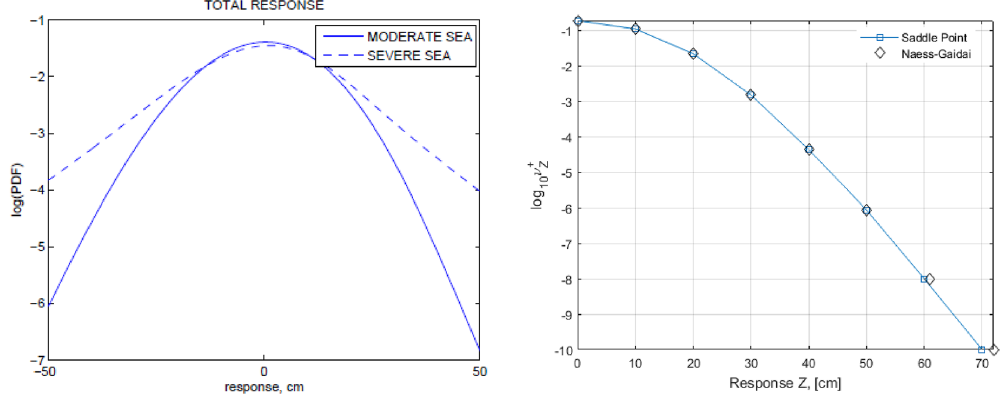
Figure 3. Left: Comparative decimal log PDF of the total response (cm), moderate sea (–) and severe sea (- -). Right: Moderate sea, response mean up-crossing rate comparison on the decimal log